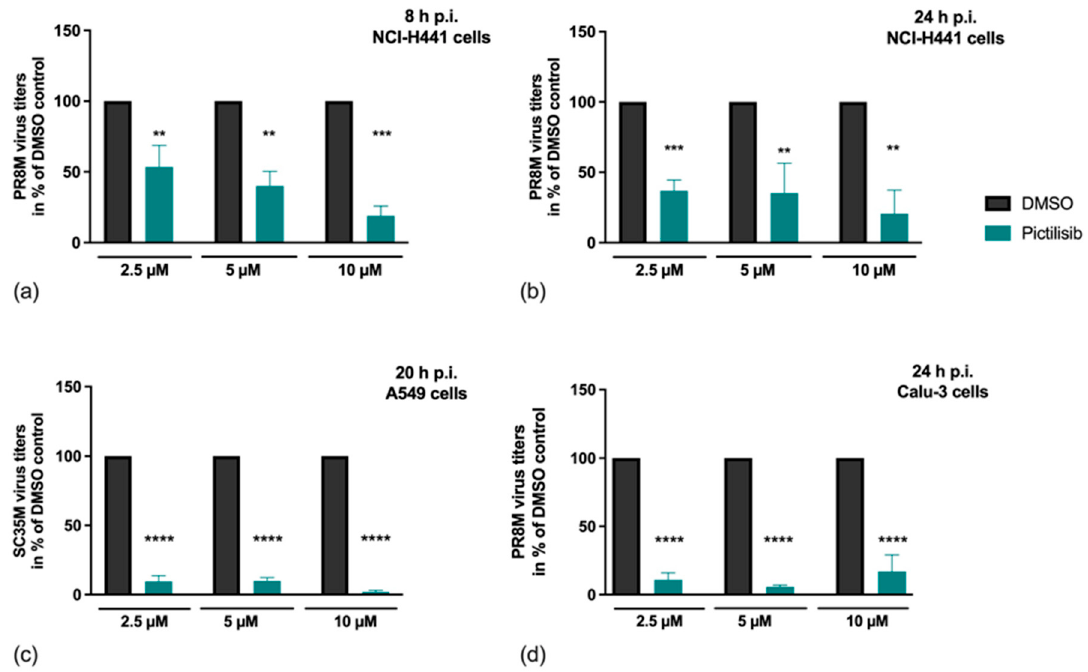
Figure 1. Efficient inhibition of viral replication upon Pictilisib treatment. ( a – d ) NCl-H441 cells ( a , b ), A549 cells ( c ) or Calu-3 cells ( d ) were pre-incubated with the indicated concentrations of Pictilisib or solvent control (DMSO) for 30 min prior to infection. Afterwards, viral infection was performed with PR8M (H1N1) for 8 h (MOI 0.5) ( a ), 24 h (MOI 0.01) ( b ), (MOI 0.5) ( d ), or SC35M (H7N7; MOI 0.001) for 20 h ( c ) in the presence of the indicated concentrations of Pictilisib or DMSO. Data represent means + SD of three independent experiments including two ( a , b , d ) or four ( c ) biological samples. DMSO-treated cells were arbitrarily set as 100%. Statistical analysis was performed by one-way ANOVA followed by multiple comparisons test. (**** p < 0.0001, *** p < 0.001, ** p < 0.01).